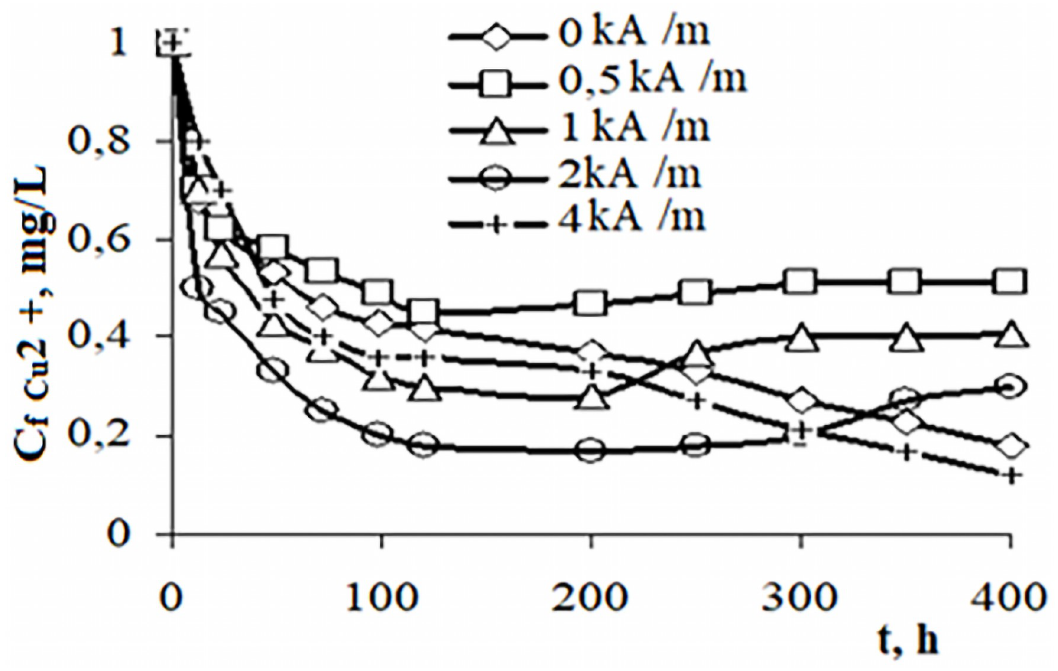
Fig 3. Comparative results on the effect of MF of different strengths on the process of the copper extraction by Lemna minor duckweed. t –time (h), Ci is initial concentration Cu 2+ mg/L = 1 mg/L, C f Cu2 + is concentration of Cu 2+ , mg/L. https://doi.org/10.1371/journal.pone.0255512.g003 Upon desorption by the plants of the accumulated excess amount of copper, a change in their appearance was observed. The initial (natural) state of Lemna minor is shown in Fig 4. On the second day under the influence of a magnetic field with a strength of H = 0.5 kA/m the duckweed changed its color from green to light green, it turned yellow on the 4th-5th day, necrosis was observed on the 10th day and then Lemna minor died. Under the influence of a magnetic field with a strength of H = 1.0 kA/m a change in the color of the plant from green to light green with a yellowish tint was also observed on the 2 nd day, on the 4th day the duckweed completely turned yellow and on the 10th day the plant died. A somewhat better result was observed under the influence of a magnetic field of H = 2.0 kA/m. On the second day a discol- oration of the leaves from green to light green with a yellow color was observed, on about the